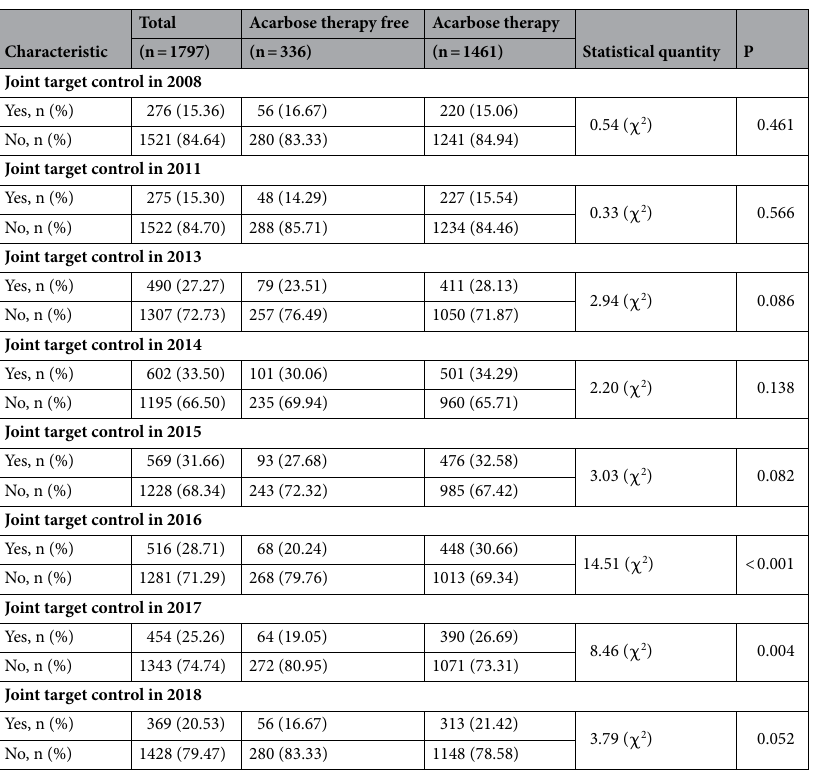
Table 3. Comparison of ratios of patients who achieved the joint target control between the two groups.